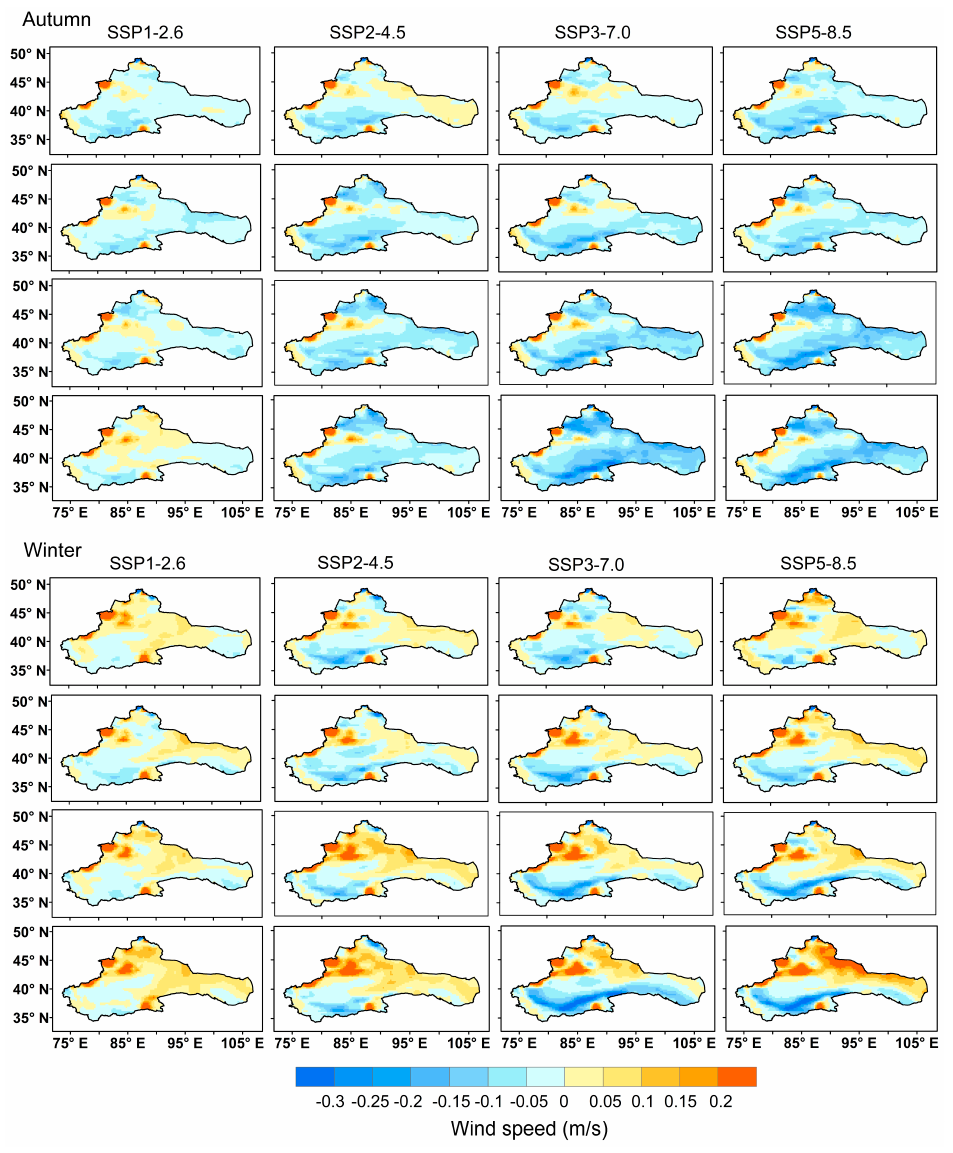
Figure 7. Spatial difference distribution of seasonal mean wind speed relative to BP in NF (row 1), MF (row 2), FF (row 3), and FP (row 4) under four emission scenarios.